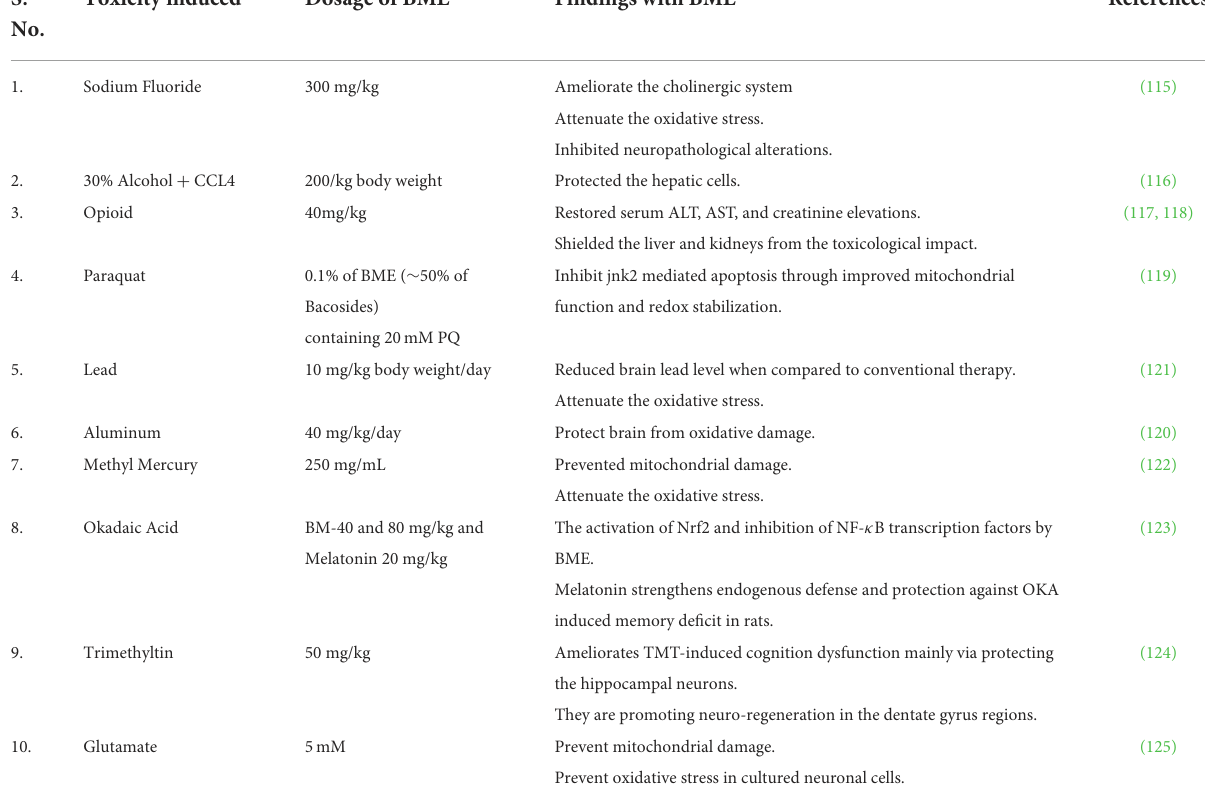
TABLE 3 Efficacy of B. monnieri to attenuate the adverse effect caused by various toxic agents.